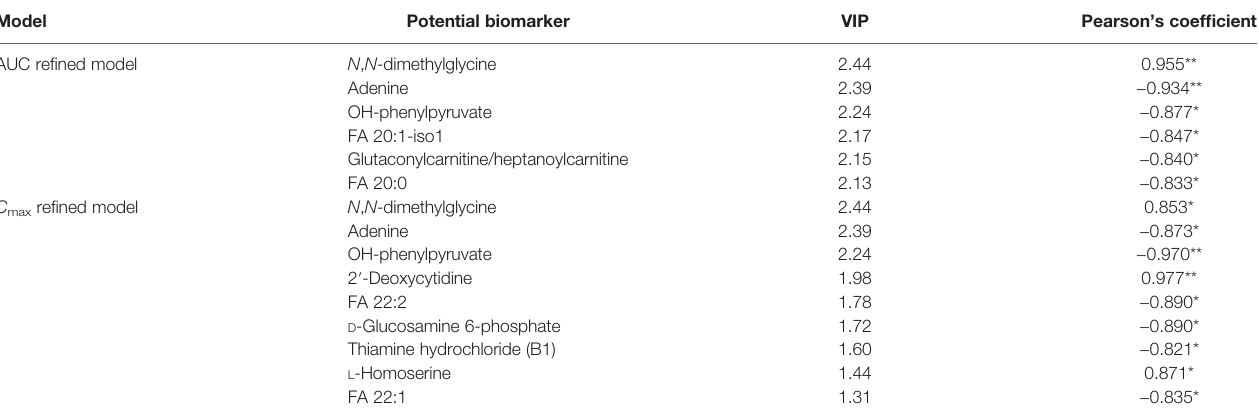
TABLE 5 | Potential predictive biomarkers for the pharmacokinetics of sotorasib.